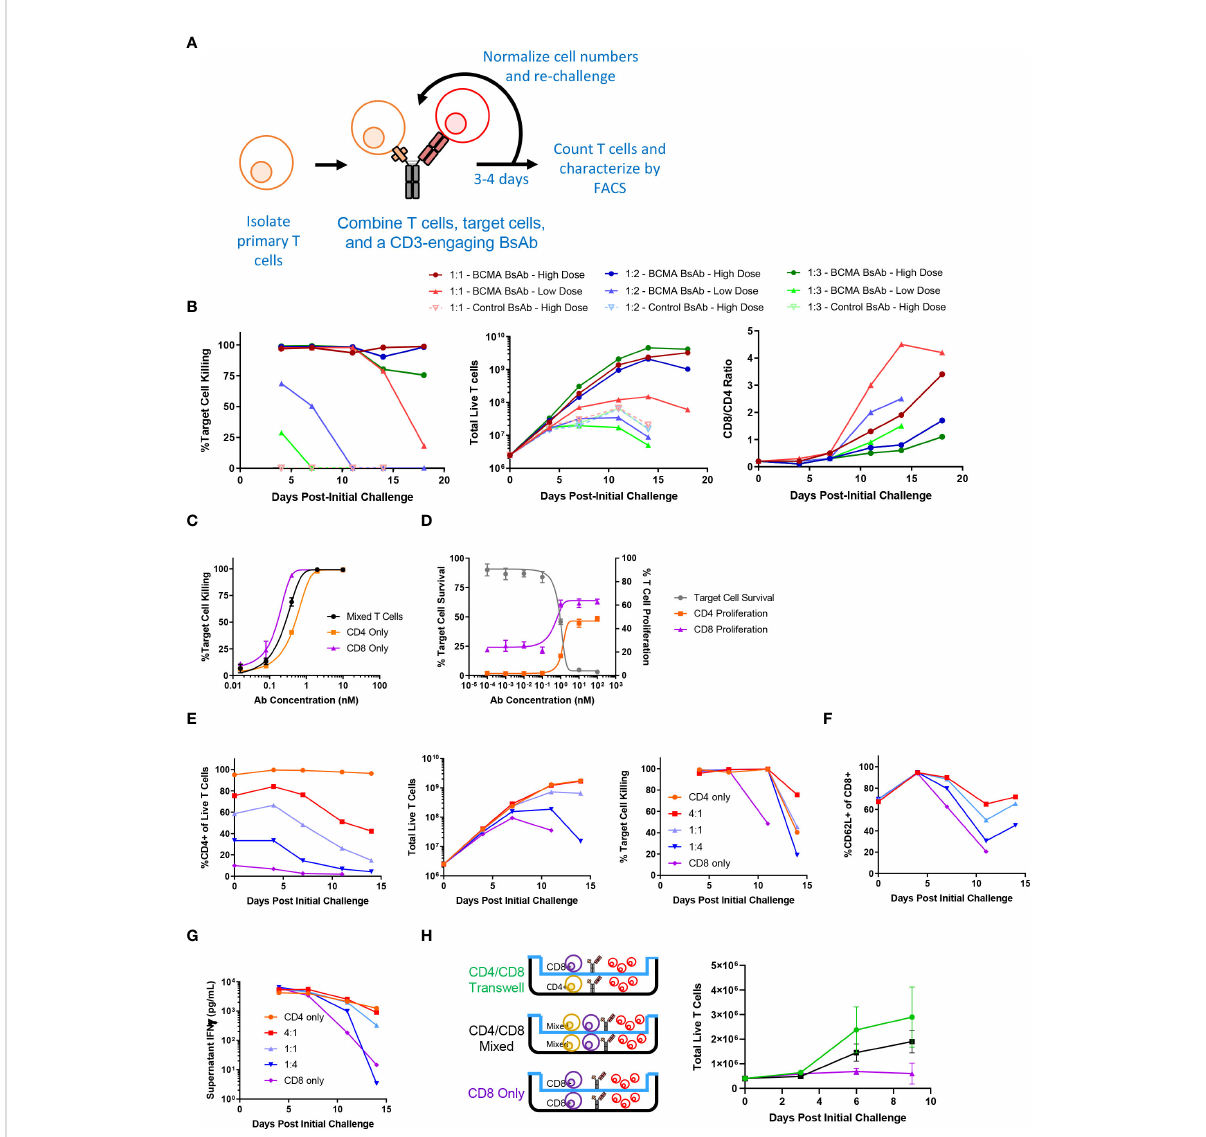
FIGURE 1 Sustained CD4+ T cell help is necessary for long-term CD3-engaging bispeci fi c antibody-mediated CD8+ T cell proliferation and tumor cell killing in vitro . (A) Schematic overview of the long-term repeat challenge assay system. (B) A long-term repeat challenge assay was established using KMS11 target cells and a BCMAxCD3 or control CD3-engaging BsAb. Challenge was repeated every 3-4 days until killing and/or proliferation activity were absent. The ef fi ciency of BsAb-mediated KMS11 target cell killing by T cells was quanti fi ed via fl ow cytometry to assess the dependence of these activities on BsAb dose and effector to target cell ratio (E:T). The ratio of CD8/CD4 cells was also evaluated over time (High BsAb dose = 3 nM, Low BsAb dose = 0.5 nM). (C) CD4+ and CD8+ T cells were negatively enriched from healthy human donor PBMCs. CD4+, CD8+, or a 1:1 mixture of CD4+ and CD8+ T cells were combined with KMS11 tumor cells containing a luciferase reporter construct (E:T – 1:1) and the indicated dose of a BCMAxCD3 BsAb for 3 days, followed by the analysis of target cell killing. (D) CFSE-labeled T cells and KMS11 target cells were combined for 3 days, after which CD4 and CD8 T cell proliferation and target cell killing were analyzed by fl ow cytometry. (E) CD4+ and CD8+ T cells were negatively enriched from healthy human donor PBMCs, and were then either maintained separately or combined at de fi ned ratios (4:1, 1:1, 1:4) in a long-term repeat challenge assay with a BCMAxCD3 BsAb and KMS11 target cells. Cell killing was monitored over time. (F) CD62L+ CD8+ T cell frequencies were monitored over time. (G) Supernatant IFN g levels were measured by ELISA in samples collected at each re-challenge time point. (H) CD4+ and CD8+ T cells were negatively enriched from two healthy donors and used in a Transwell repeat challenge assay as shown, with proliferation of cells in the upper chamber being quanti fi ed over time. Data in (B) are representative plots from a single donor. All experiments were repeated a minimum of three times, except for (H) which was repeated two